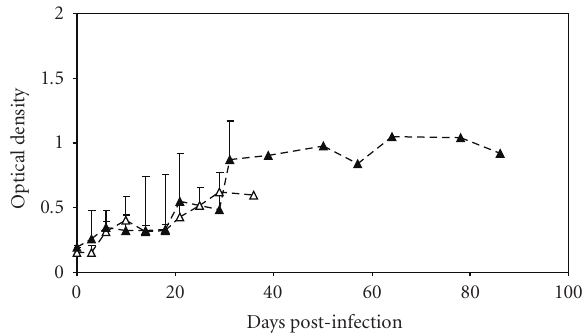
Figure 4: Immunoglobulin profile in serum of mice infected with T. cruzi I strains. Mice were inoculated ip with 1 × 10 4 T. cruzi BT of Ninoa ( ) or Qro ( ) strains. IgG antobodies were determined (cid:0) (cid:2) by ELISA as described in materials and methods and are showed as media value ±